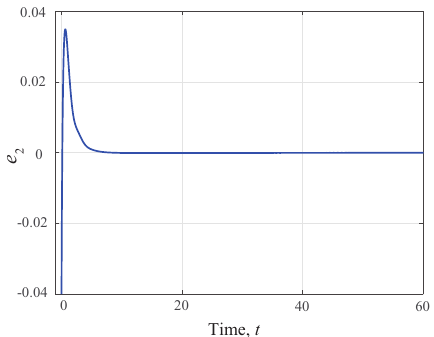
Figure 2. Time evolution of tracking error e 1 ( t ) .